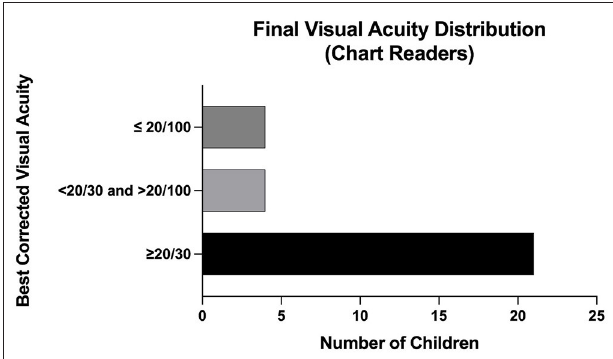
TABLE 2 | Chronic neurological diagnoses in study